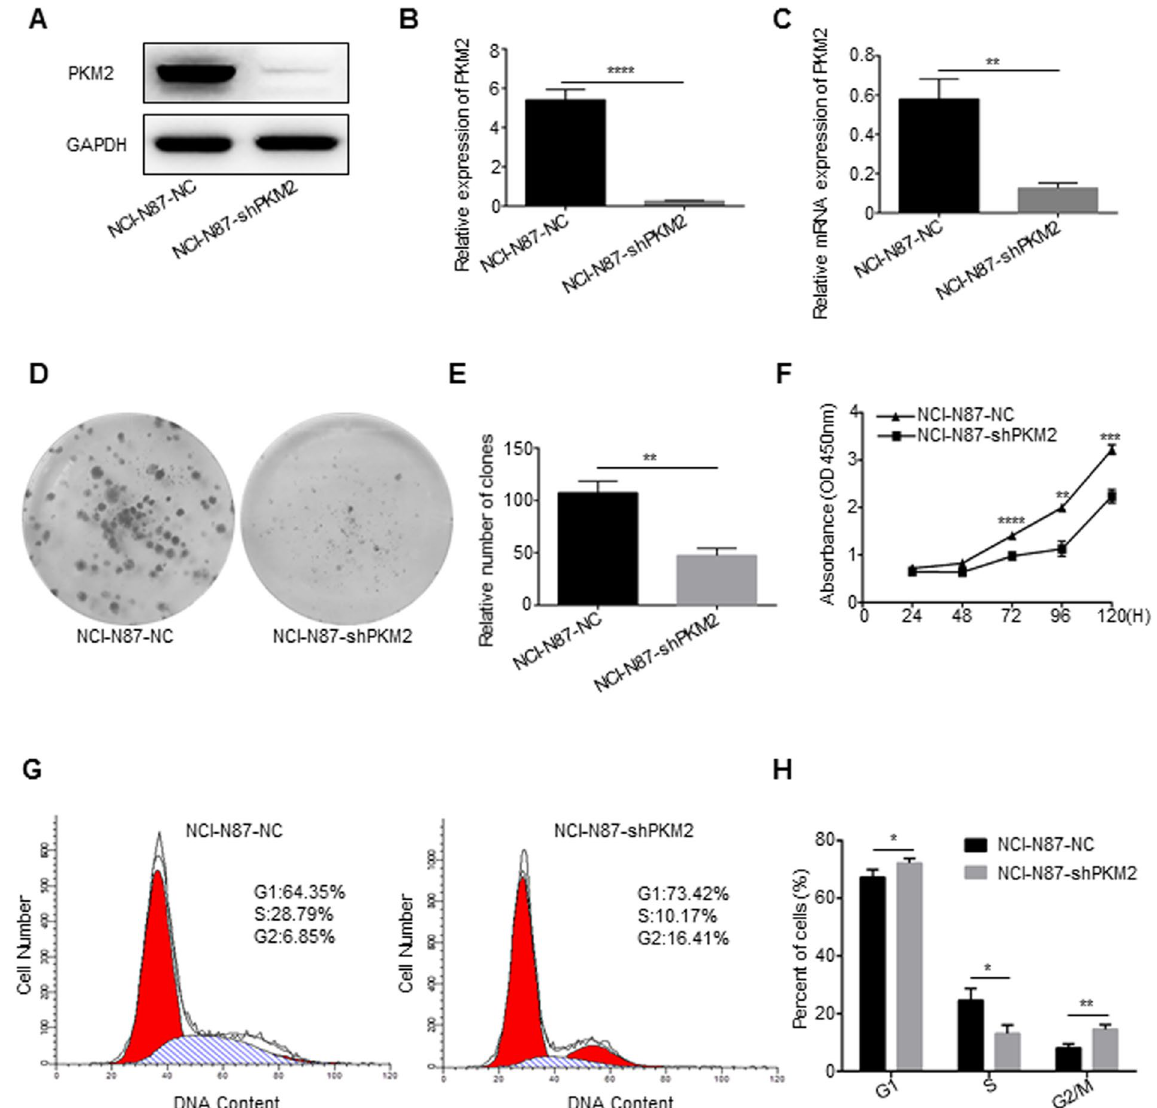
Figure 2. Effect of PKM2 knockdown on NCI-N87 cell growth in vitro and cell cycle. ( A , B and C ) PKM2 expression in NCI-N87 was modified by shRNA interference and verified with western blot and qRT-PCR, quantitative western blot analysis results obtained using densitometric analysis and the mRNA expression levels which were standardized according to GAPDH. Full-length gels and blots are presented in the Supplementary files 2. ( D and E ) Knockdown of PKM2 in NCI-N87 attenuated the ability of colony formation, data were shown as mean ( ± SD) from three independent experiments. ( F ) Knockdown of PKM2 in NCI-N87 attenuated the ability of cell proliferation which was detected by CCK-8 assay. ( G and H ) Knockdown of PKM2 attenuated the G1-S phase transition in NCI-N87, data were shown as mean ( ± SD) from three independent experiments. * P < 0.05. ** P < 0.01. *** P < 0.001. **** P <